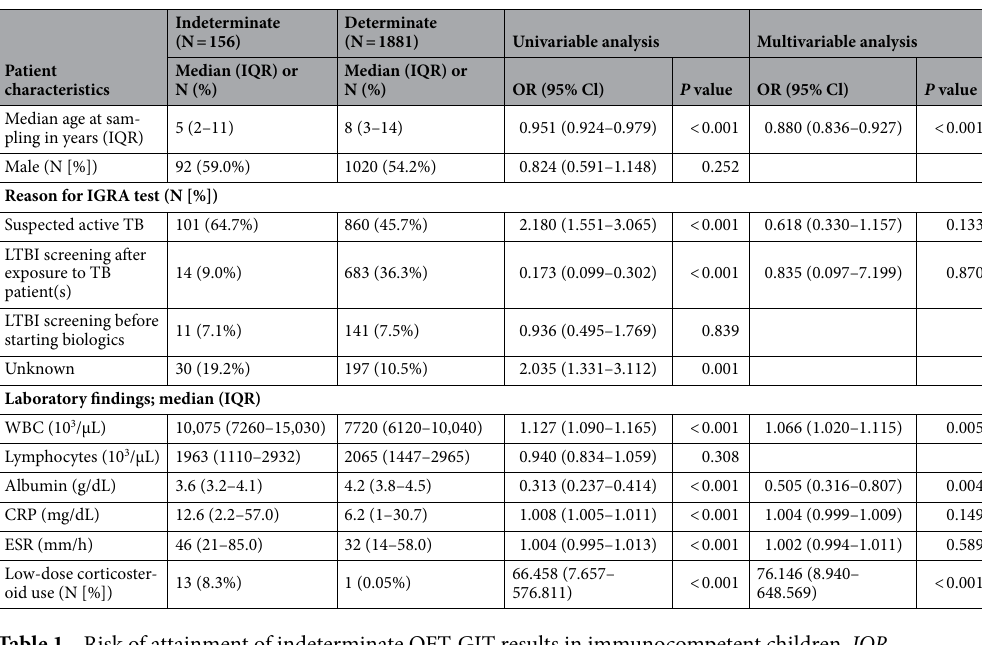
Table 1. Risk of attainment of indeterminate QFT-GIT results in immunocompetent children. IQR interquartile range, IGRA interferon gamma release assays, LTBI latent tuberculosis infection, TB tuberculosis,